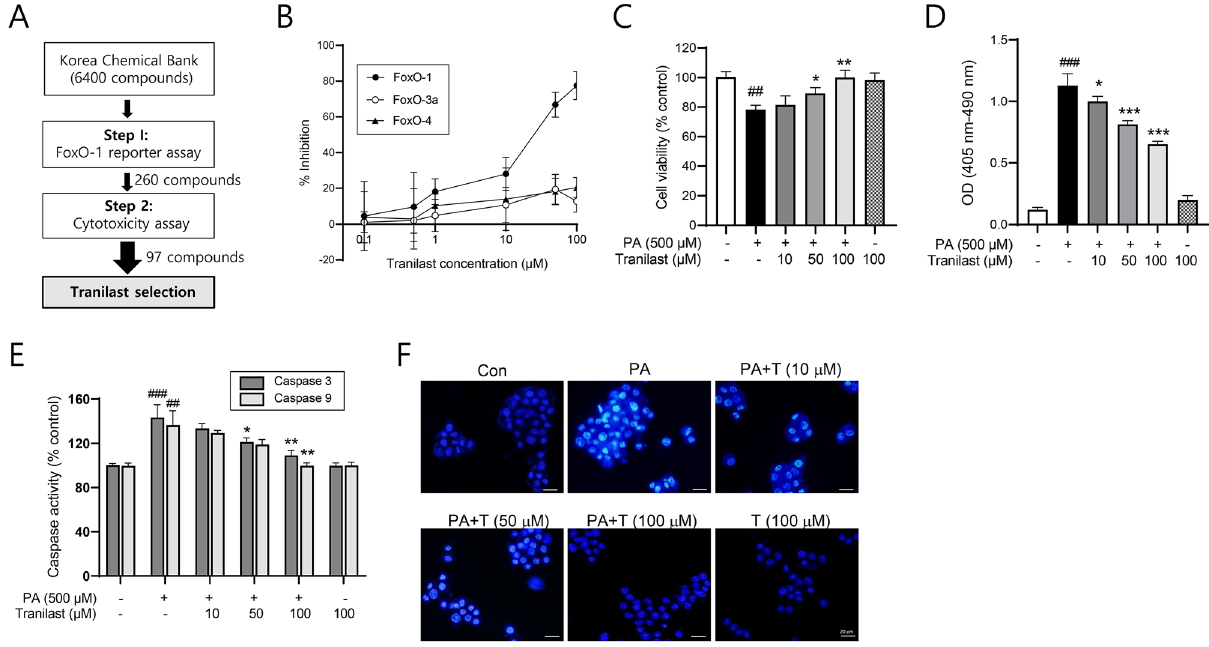
Figure 1. Tranilast protects INS-1 cells from PA-induced cell death. ( A ) Schematic representation of tranilast selection from high throughput screening of Korea Chemical Bank. ( B ) Inhibitory effects of tranilast on FoxO-1, 3a, and 4 were determined using HepG2 cells after transfection with FoxO-1 vector, and IRE vector as described in Methods. ( C ) Effect of tranilast on cell viability was measured using MTT assay following incubation of INS-1 cells with PA (500 μM) for 24 h in the presence or absence of tranilast at the indicated concentrations. ( D ) INS-1 cells were treated with PA (500 μM) for 24 h in the presence or absence of various concentrations of tranilast. Induction of apoptosis was measured using a cell death detection ELISA kit. ( E ) Caspase-3 and -9 activities were measured using the chromogenic substrates Ac-DEVD-pNA and Ac-LEHD-pNA, respectively. ( F ) DAPI staining of INS-1 cells following incubation with PA and tranilast. Representative results are shown (scale bar = 20 μm). Data are expressed as mean ± standard deviation (SD) of three independent experiments, each done in duplicate. ## p < 0.01, ### p < 0.005 versus control, * p < 0.05, ** p < 0.01, *** p < 0.005 versus PA